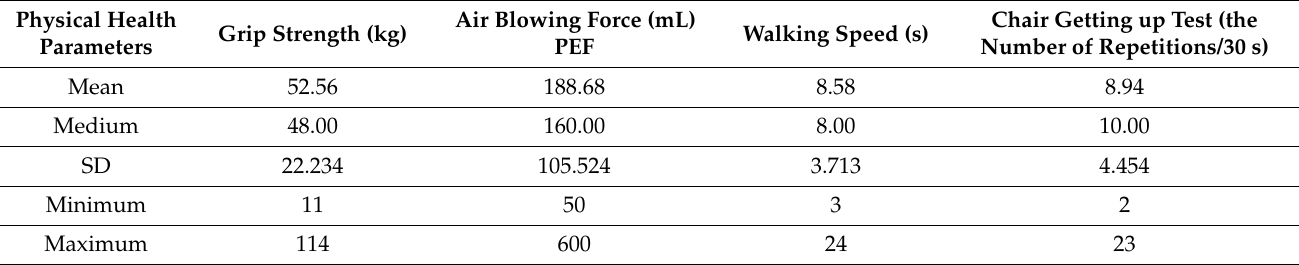
Table 2. Objective measures of the subjects’ physical health (n = 103).